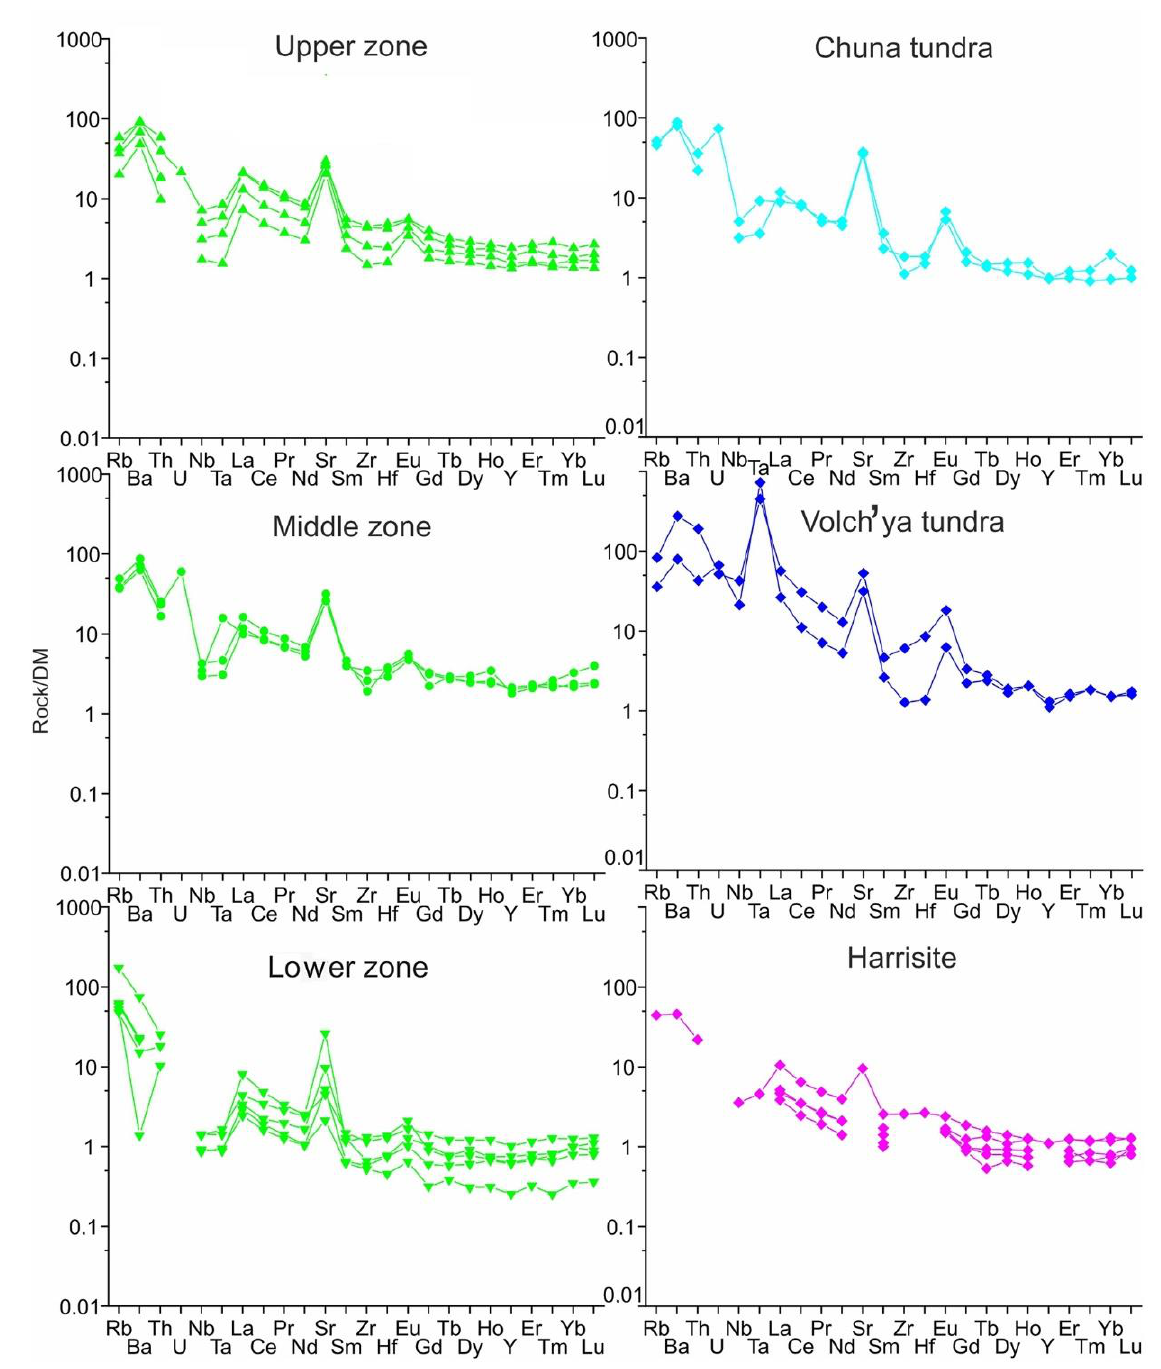
Figure 13. Spider-diagram of rocks in the massifs of Monchetundra, Chunatundra, and Volchetundra, as well as the harrisite, normalized to DM [32].